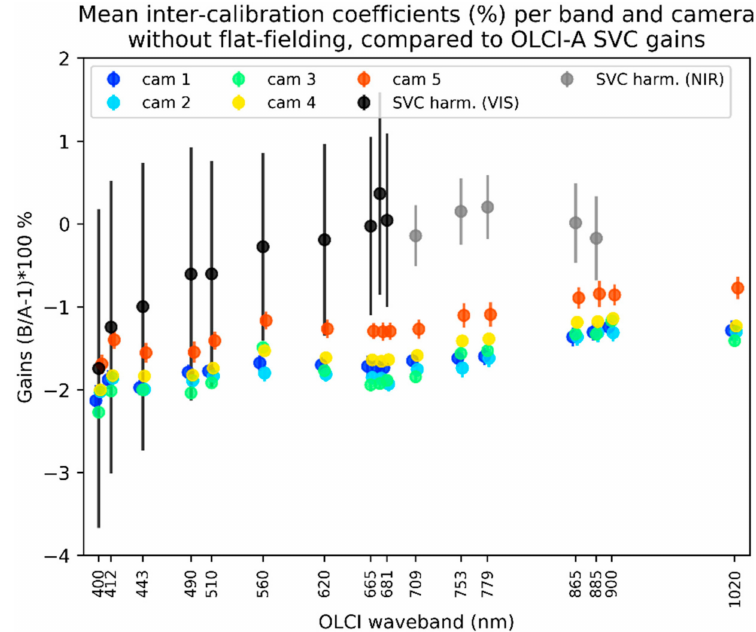
Figure 4. Comparison between the mean harmonisation factors per camera (one colour per camera) from [2] and the tentative set of SVC harmonisation gains along with their dispersion (black for VIS absolute gains, grey for NIR relative gains), gain at 1020 nm falls out of the scale and is not